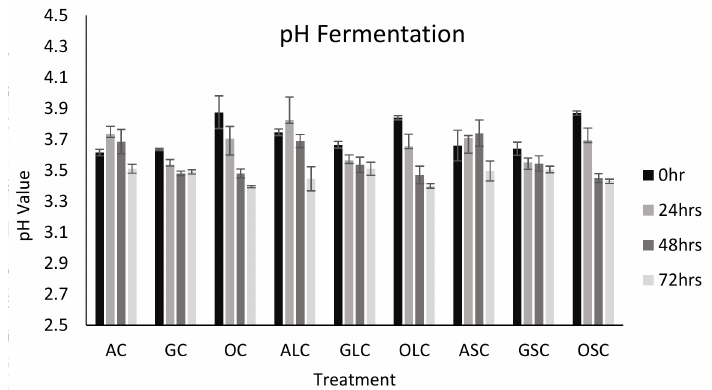
Figure 1. pH values of the various fruit juice samples taken over 72 h of fermentation. AC, GC, OC (apple, grape, and orange juice control); ALC, GLC, OLC (orange, grape, and orange juice with